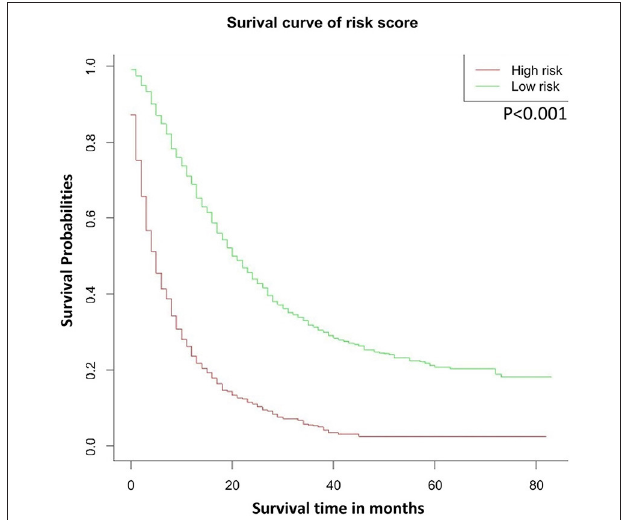
FIGURE 4 | OS stratified by the risk levels of the nomogram-predicted survival probabilities. OS, overall survival.